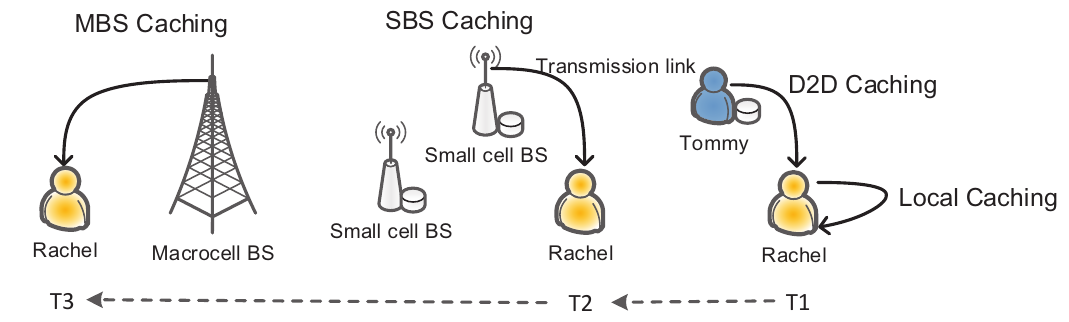
Figure 1. Illustration of the protocol for content